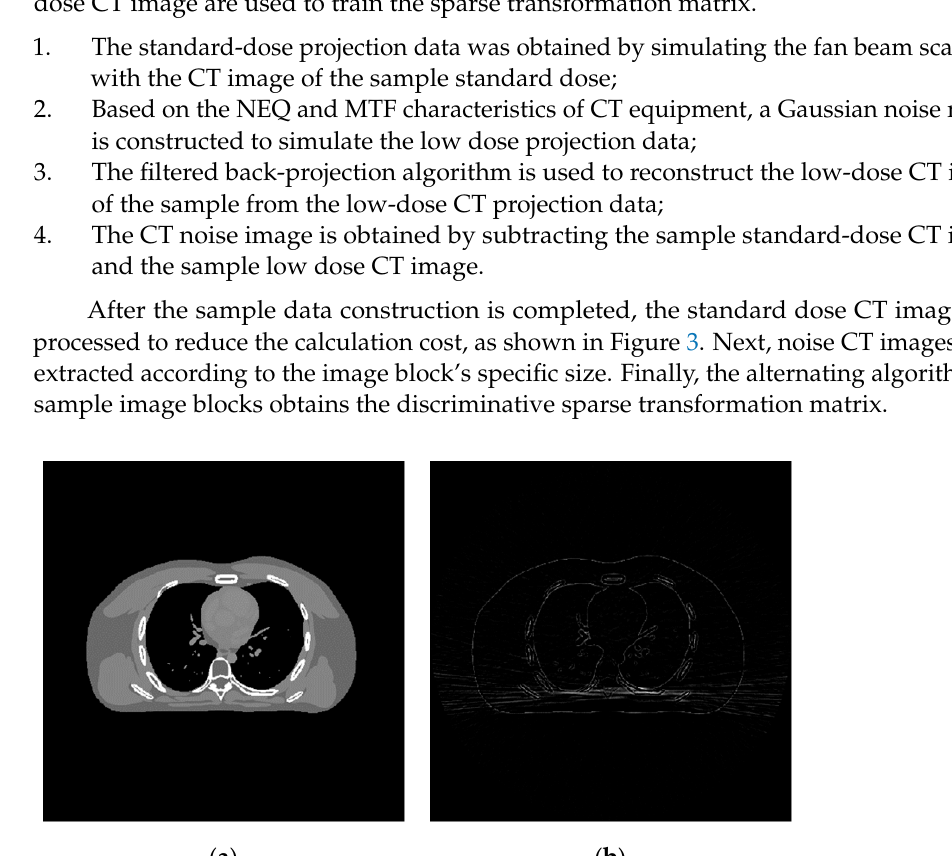
Figure 3. Training image. ( a ) Standard dose; ( b ) noise CT